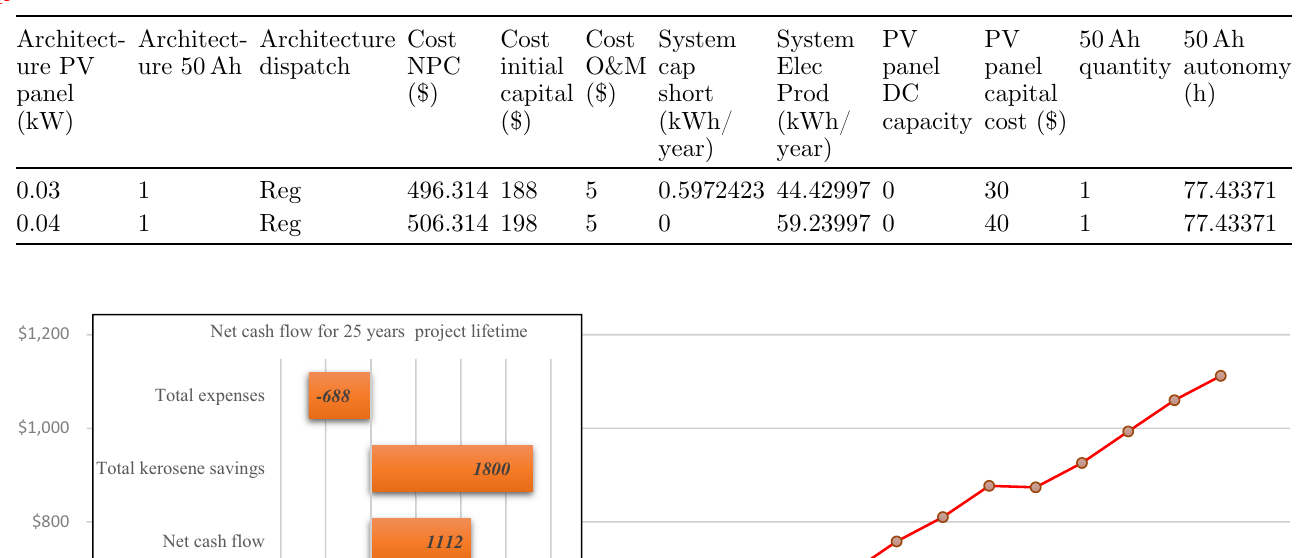
Table 2. Optimisation results Q5 for the proposed system simulation tabulated results.